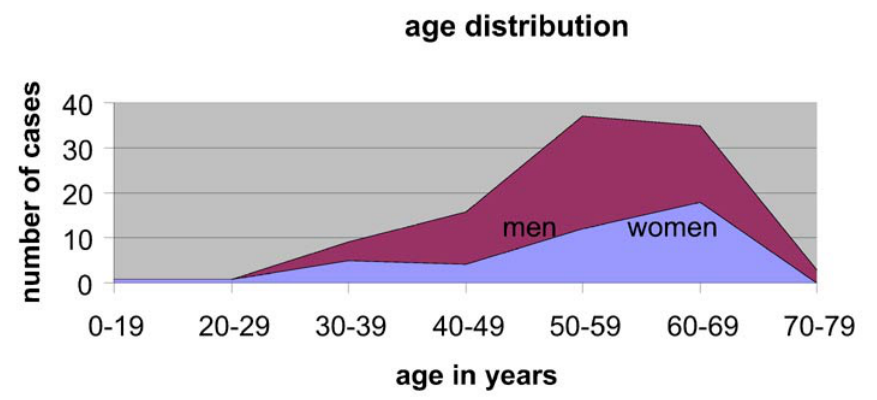
FIGURE 1. Age distribution of 103 patients with pulmonary hamartomas.